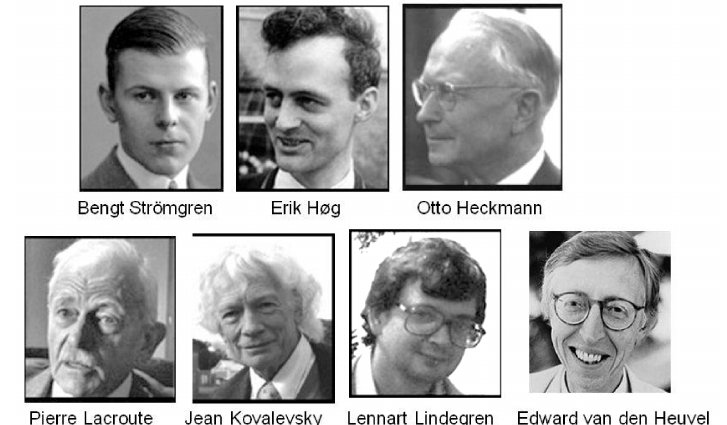
Fig. 5. The development of photoelectric astrometry since 1925 and of the Hipparcos project was critically dependent on every one of the first six of these astronomers up to the approval in 1980. The seventh, Edward van den Heuvel, strongly advocated Hipparcos in the ESA decision process in 1980 although he himself as an X-ray astronomer had a direct interest in the competing EXUV